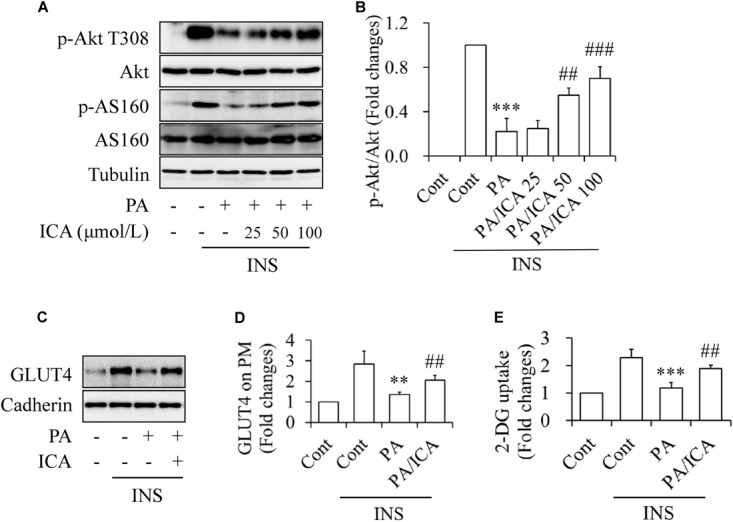
Impacts of icariin on PA-induced insulin resistance in C2C12 myotubes. (A,B) Dose–response effect of icariin (ICA) on insulin (INS)-stimulated phosphorylation of Akt T308 and AS160. (C,D) Effect of ICA on INS-stimulated GLUT4 translocation on plasma membrane. (E) Effect of ICA on INS-stimulated 2-deoxy-D-glucose (2-DG) uptake. N = 4. ∗∗p < 0.01, ∗∗∗p < 0.001 vs. control (Cont)/INS group; ##p < 0.01, ###p < 0.001 vs. PA/INS group.